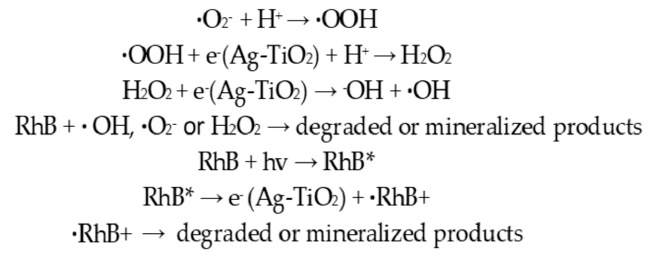
Pharmaceutics 2023 , 15 , x FOR PEER REVIEW Figure 15. Photocatalytic degradation reactions of RhB. Figure 15. Photocatalytic degradation reactions of RhB.